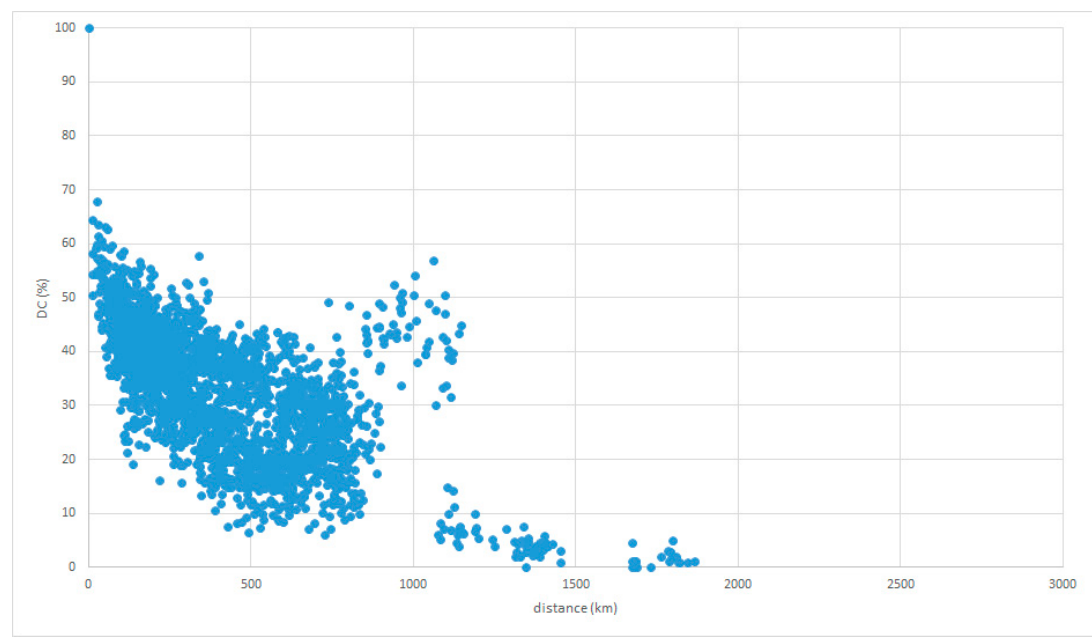
Figure 6. LAJ data with reference place in Tokaitosan.